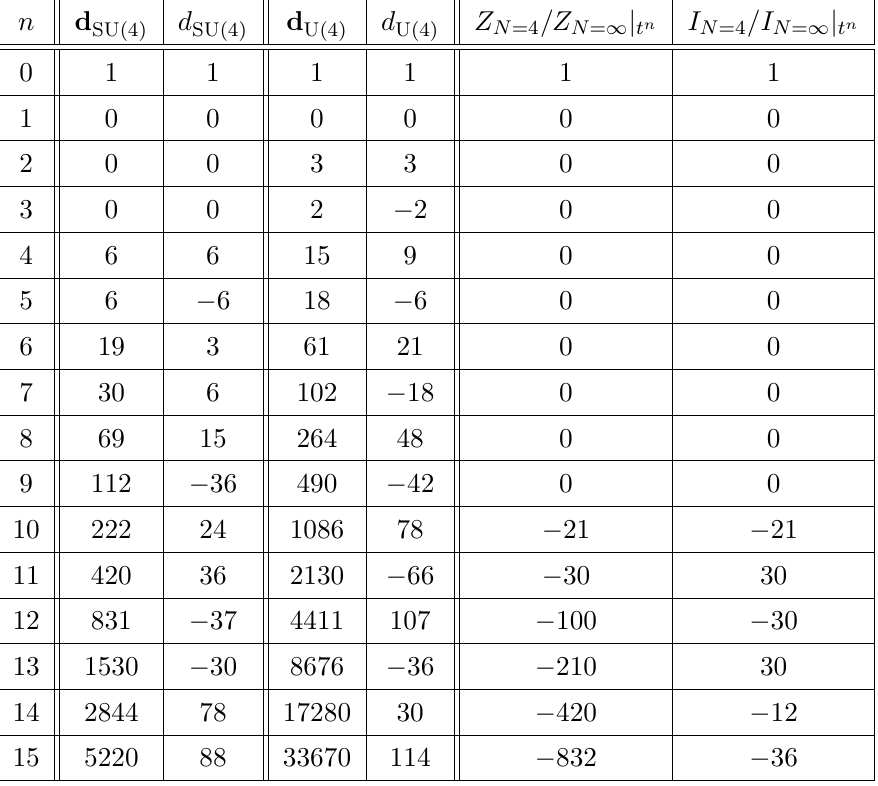
Table 5 . Counting of 1/16-BPS states for SU(4) and U(4) gauge groups, and the coefficients of Z N =4 /Z N = ∞ and I N =4 /I N = ∞